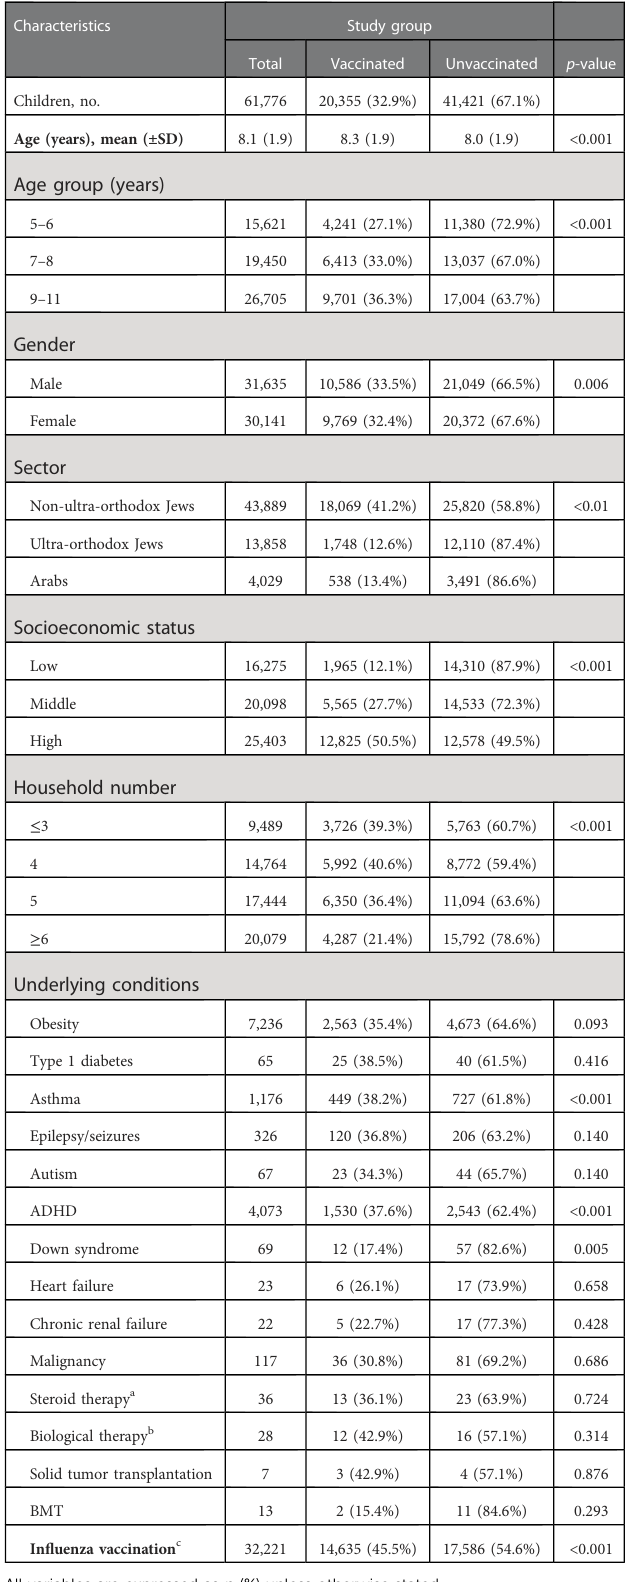
TABLE 1 Study group variables associated with vaccination rates against COVID-19 ( ≥ 1